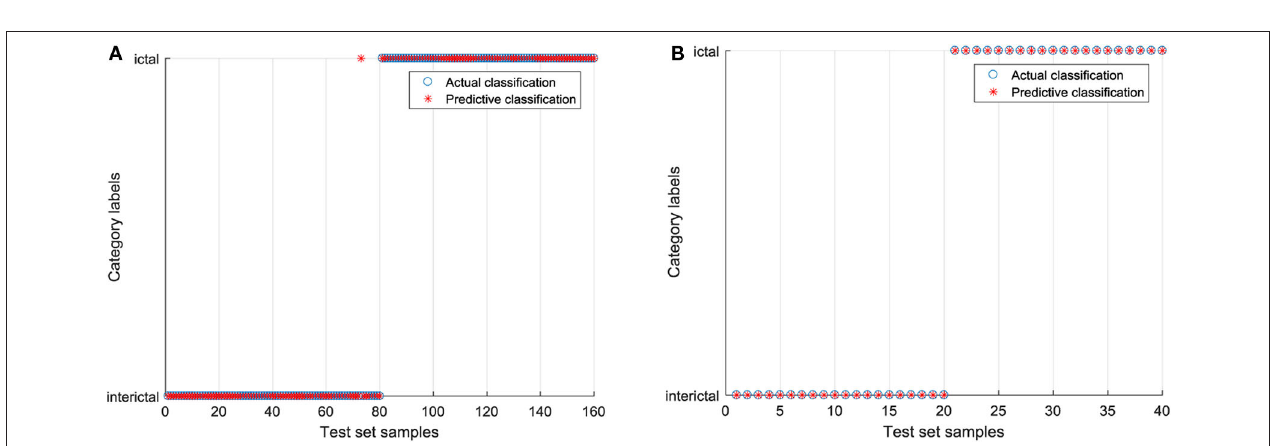
FIGURE 8 | The EEG signals processed by CEEMD are classified by GWO-SVC. (A) Classification diagram of training set and (B) Classification diagram of test